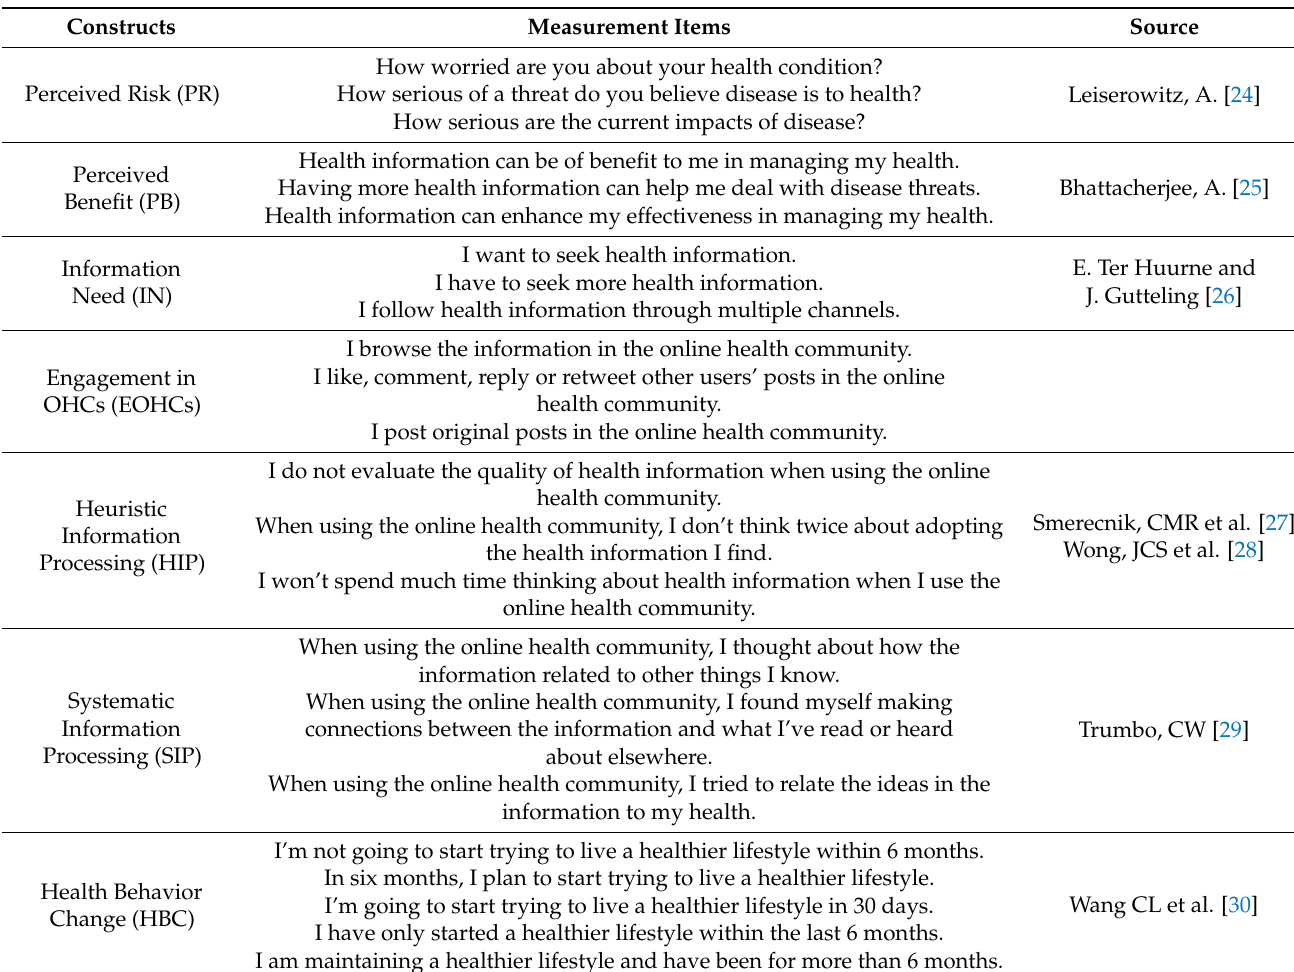
Table 1. Measurement items of the